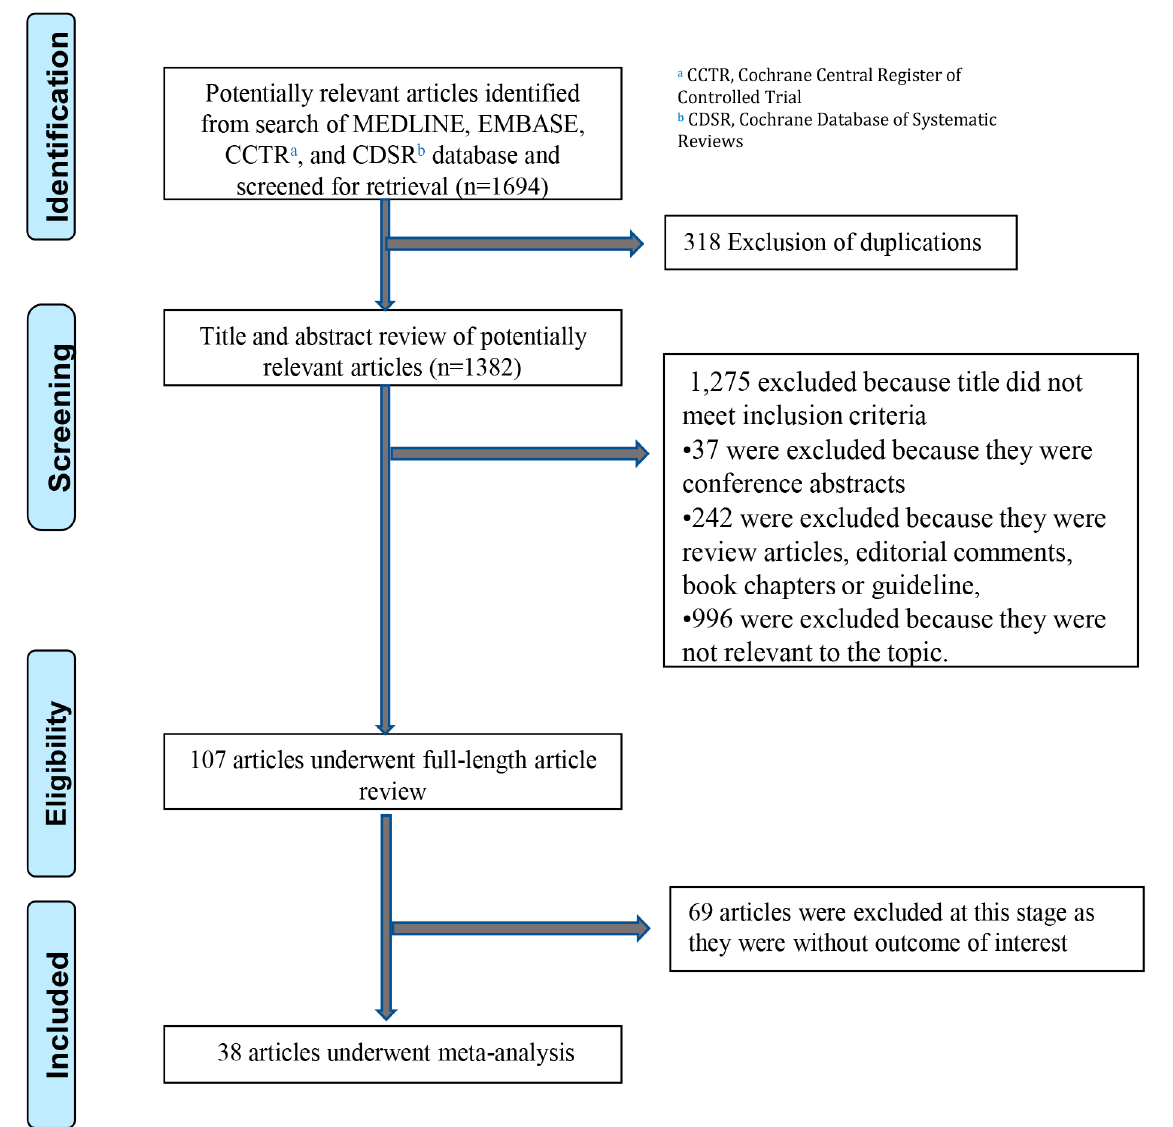
Figure 1. Literature review process.